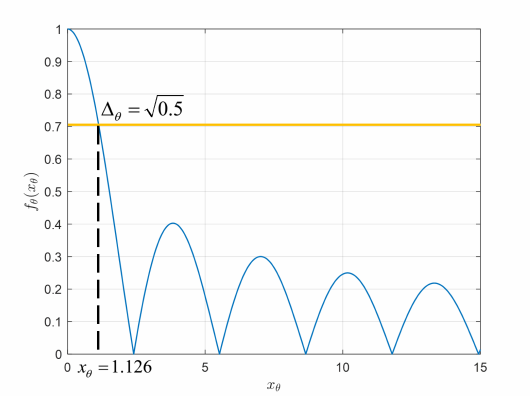
Figure 5. The numerical results of f θ ( x θ ) against x θ .